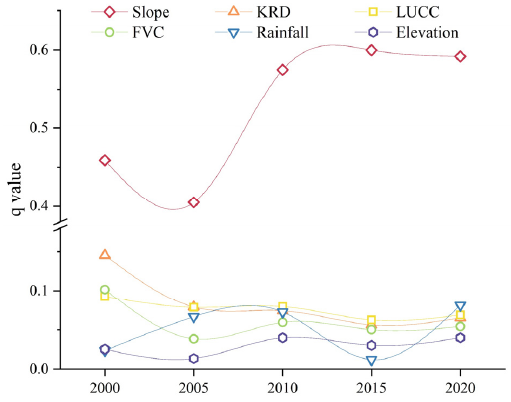
Figure 8. Single-factor